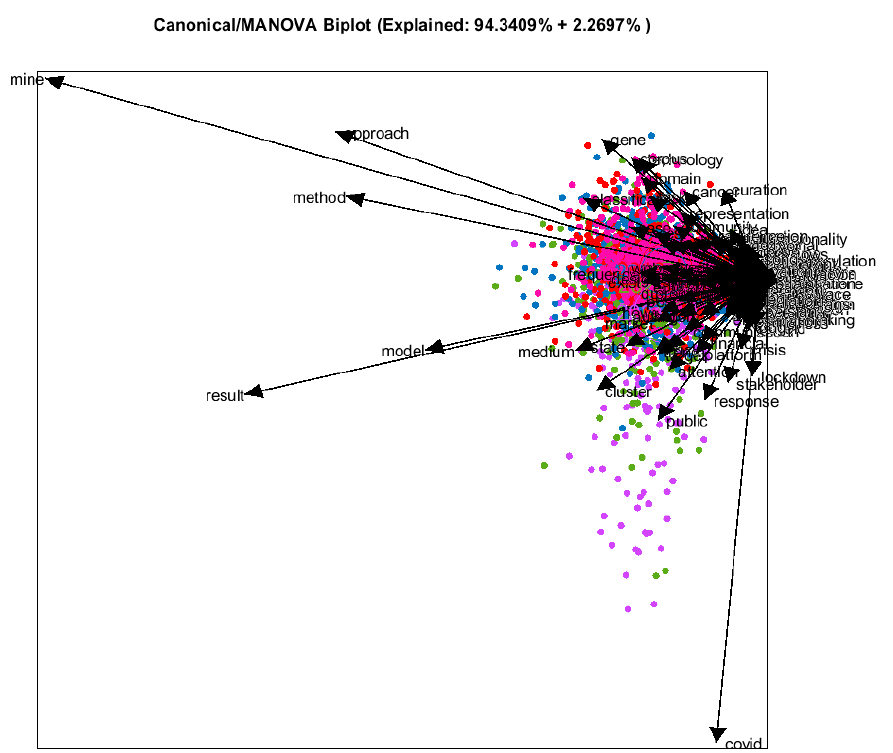
Figure 15. SRL of text mining using MANOVA Biplot.